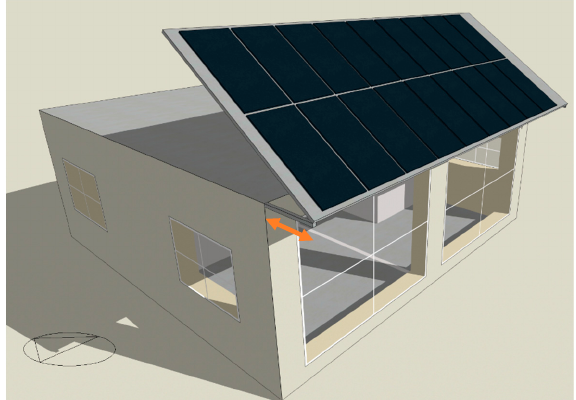
Figure 7. An example of the shading of the southern facade of the modular house with a sliding sun shade element in the form of PV panels on 15 March at 11:00.